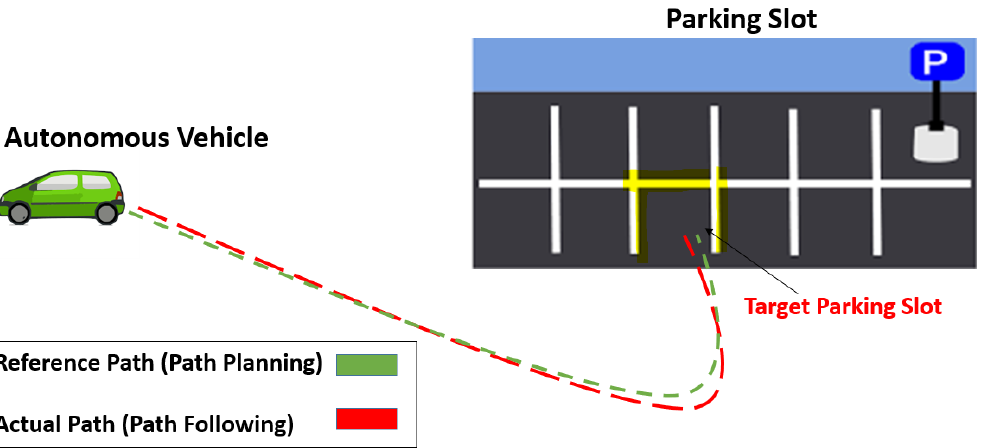
Figure 1. Concept of autonomous rear parking (ARP). The area surrounded by the yellow lines represents the target parking slot. The dotted green and red lines represent the reference path by path planning and the actual path by path following, respectively.